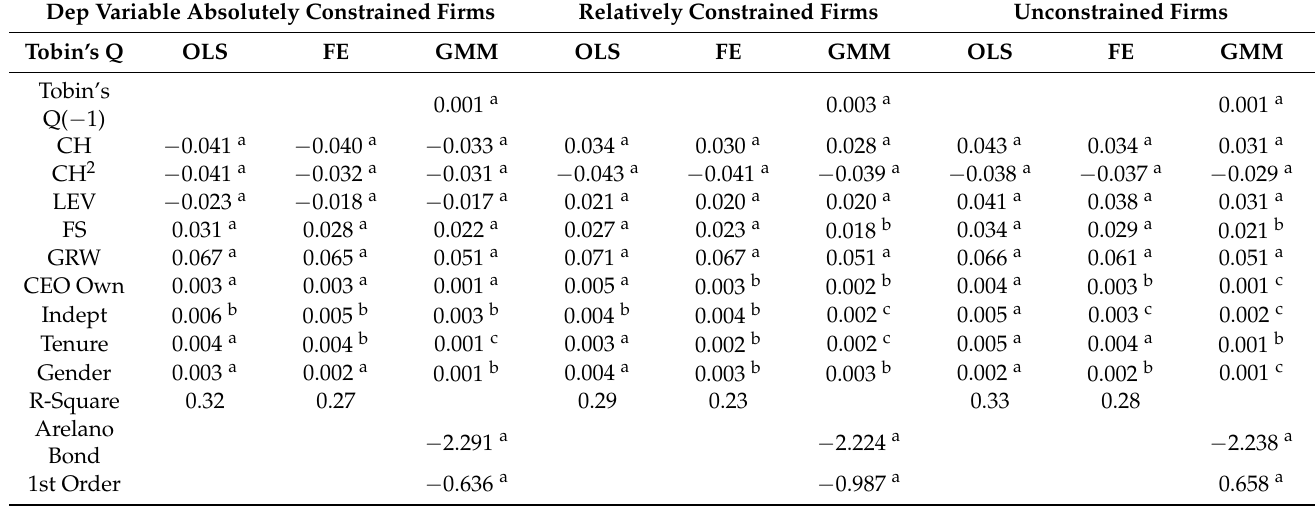
Table 8. Relationships between the cash holding and the value of